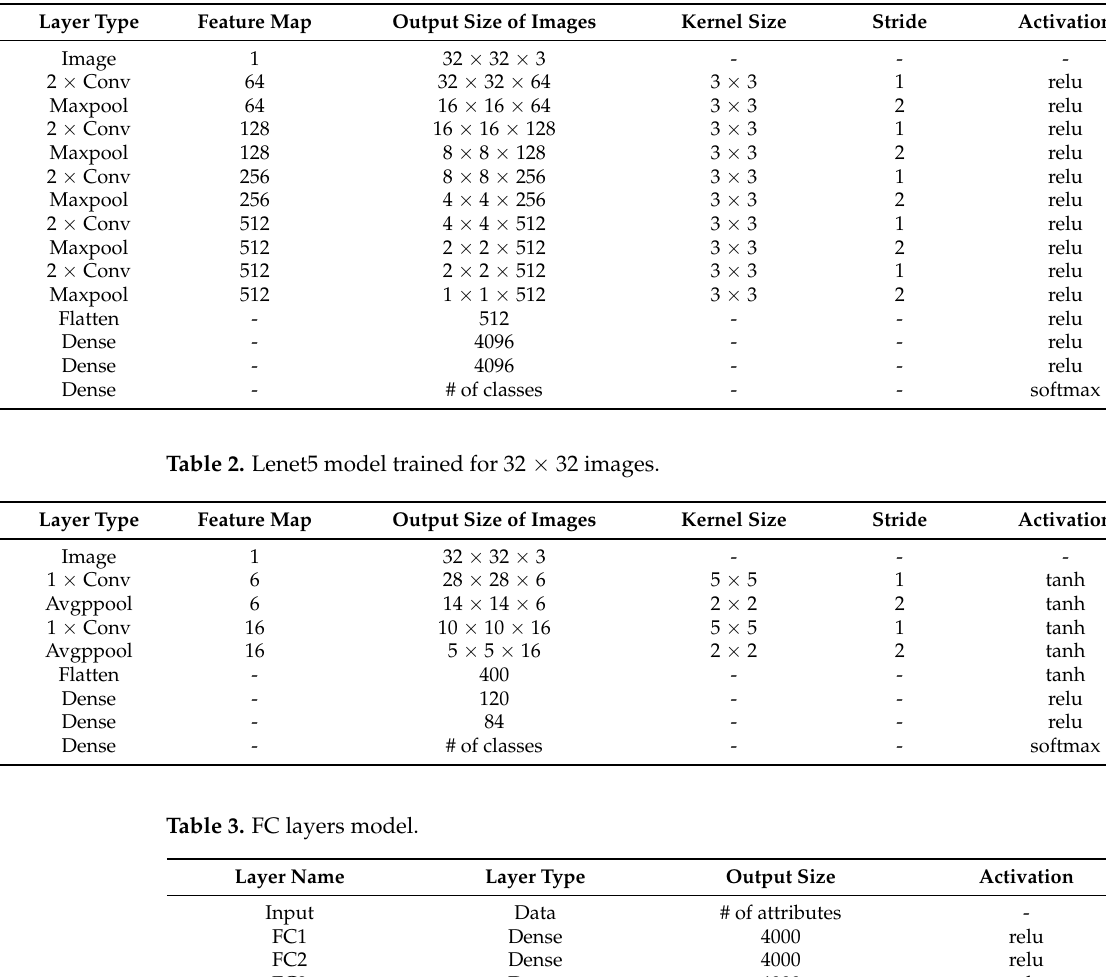
Table 1. VGG16 model trained for 32 × 32 images.